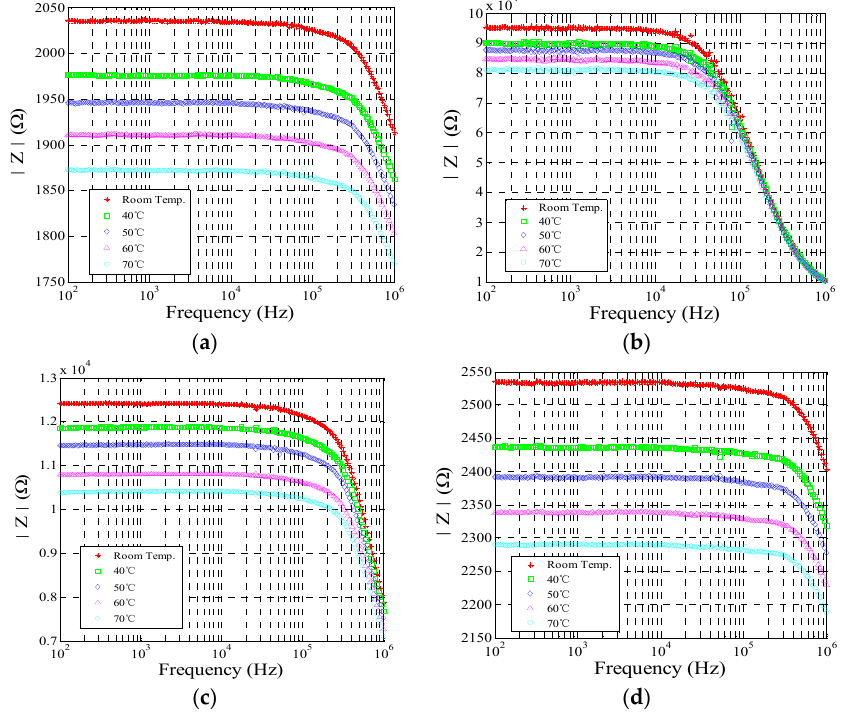
Figure 6. Impedance spectrum of the MWCNT film and polymer/MWCNT composite film at different operating temperatures. ( a ) MWCNT film; ( b ) EC/MWCNT film; ( c ) PEO/MWCNT; and ( d ) PVP/MWCNT.